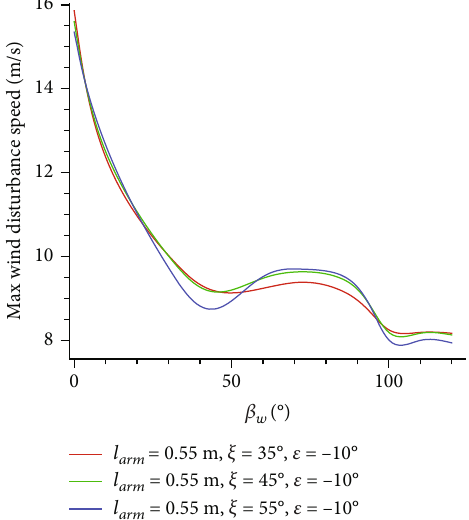
Figure 44: In fl uence of the ξ on the wind disturbance rejection performance as rotor inclined.